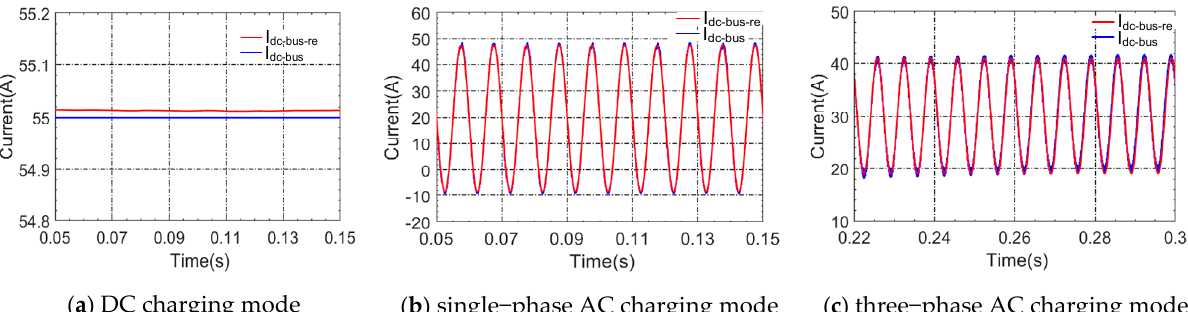
Figure 4. Comparison of theoretical calculation and simulation.